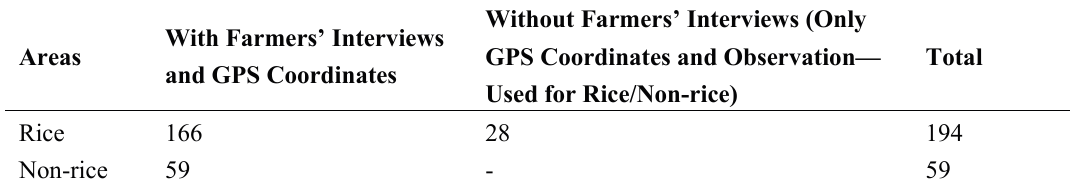
Table 2. Number of rice fields and non-rice areas visited for data